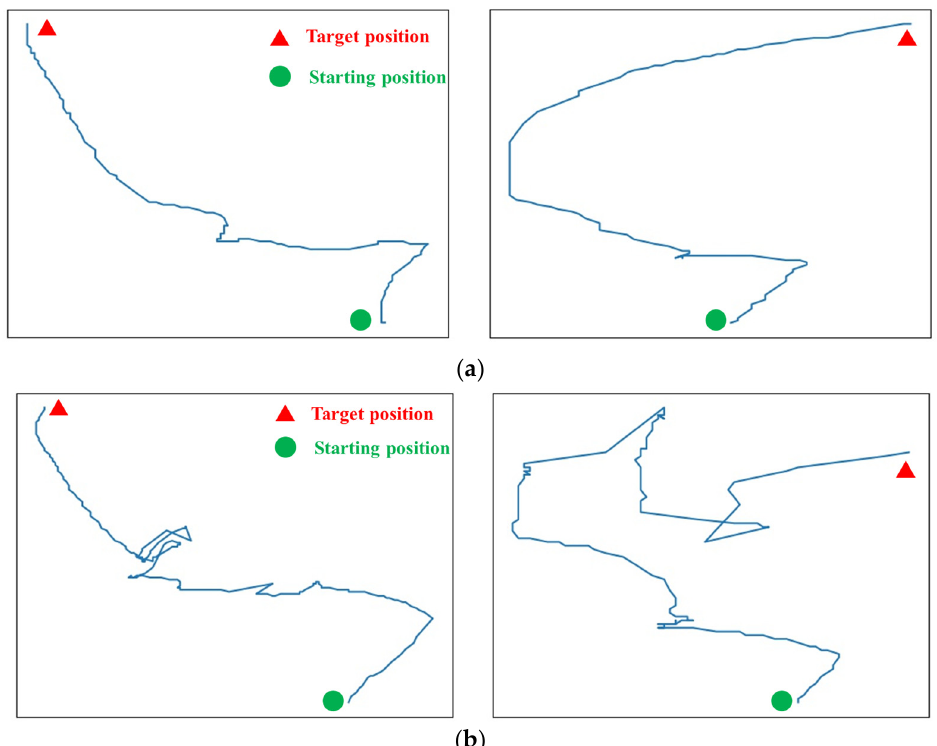
Figure 4. The motion trajectory of the guidewire tip during two intravascular tasks performed by ( a ) expert surgeons and ( b ) novice surgeons, respectively.